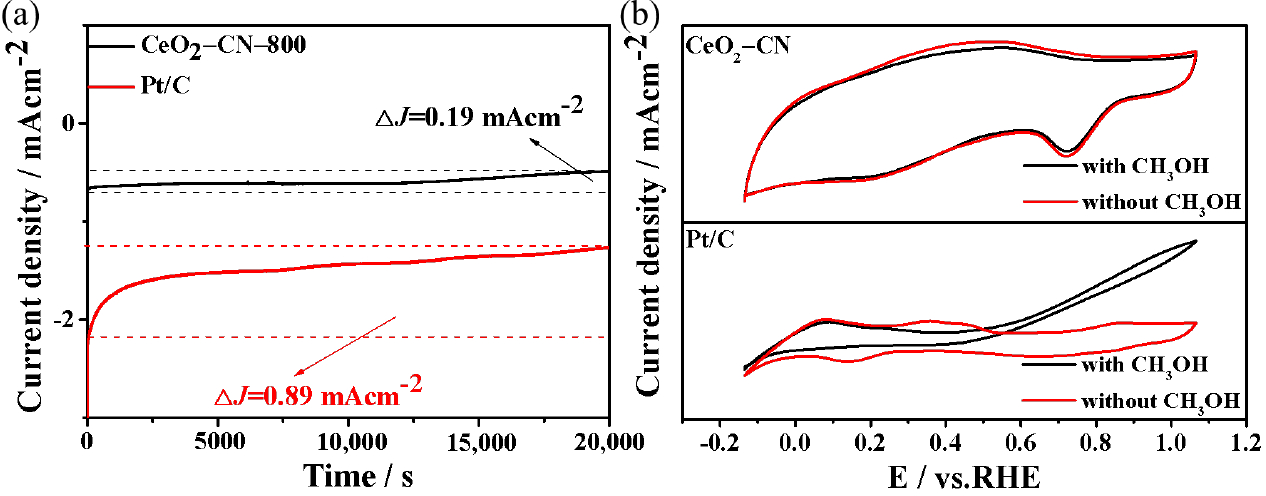
Figure 4. ( a ) i-t stability curves; ( b ) CV diagrams of CeO 2 – CN – 800 and Pt/C before and after adding